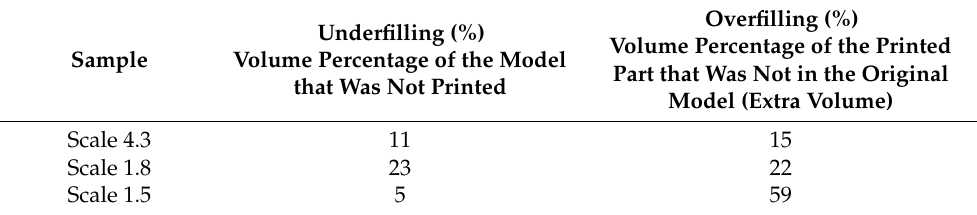
Table 8. Quantification of underfilling and overfilling for printed models of different scales (1.5, 1.8 and